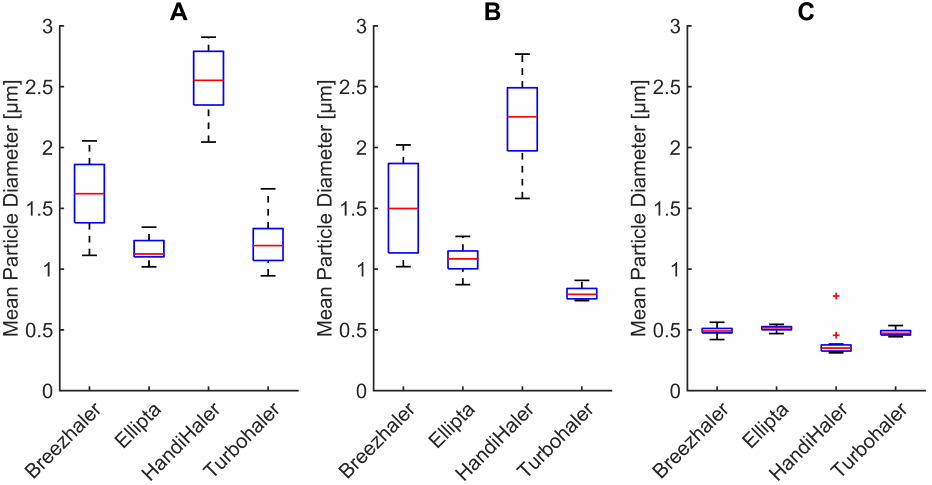
Figure 5. Changes in mean particle diameter during ( A ) characterization measurements, ( B ) inhala- tion measurements, and ( C ) exhalation measurements for four commercial